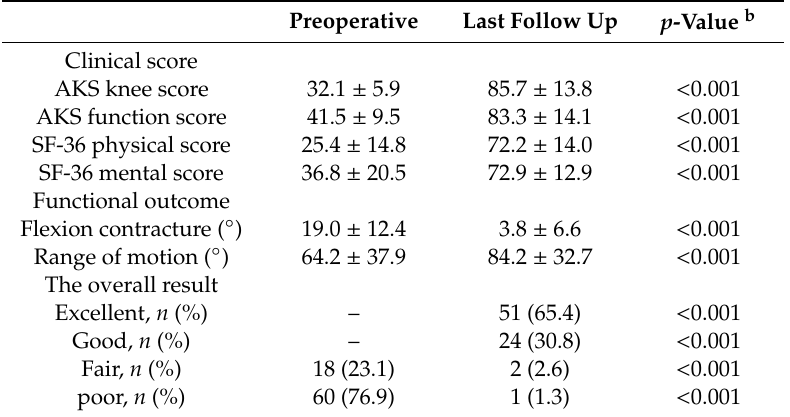
Table 4. Clinical outcomes between the preoperative and the latest follow up a .